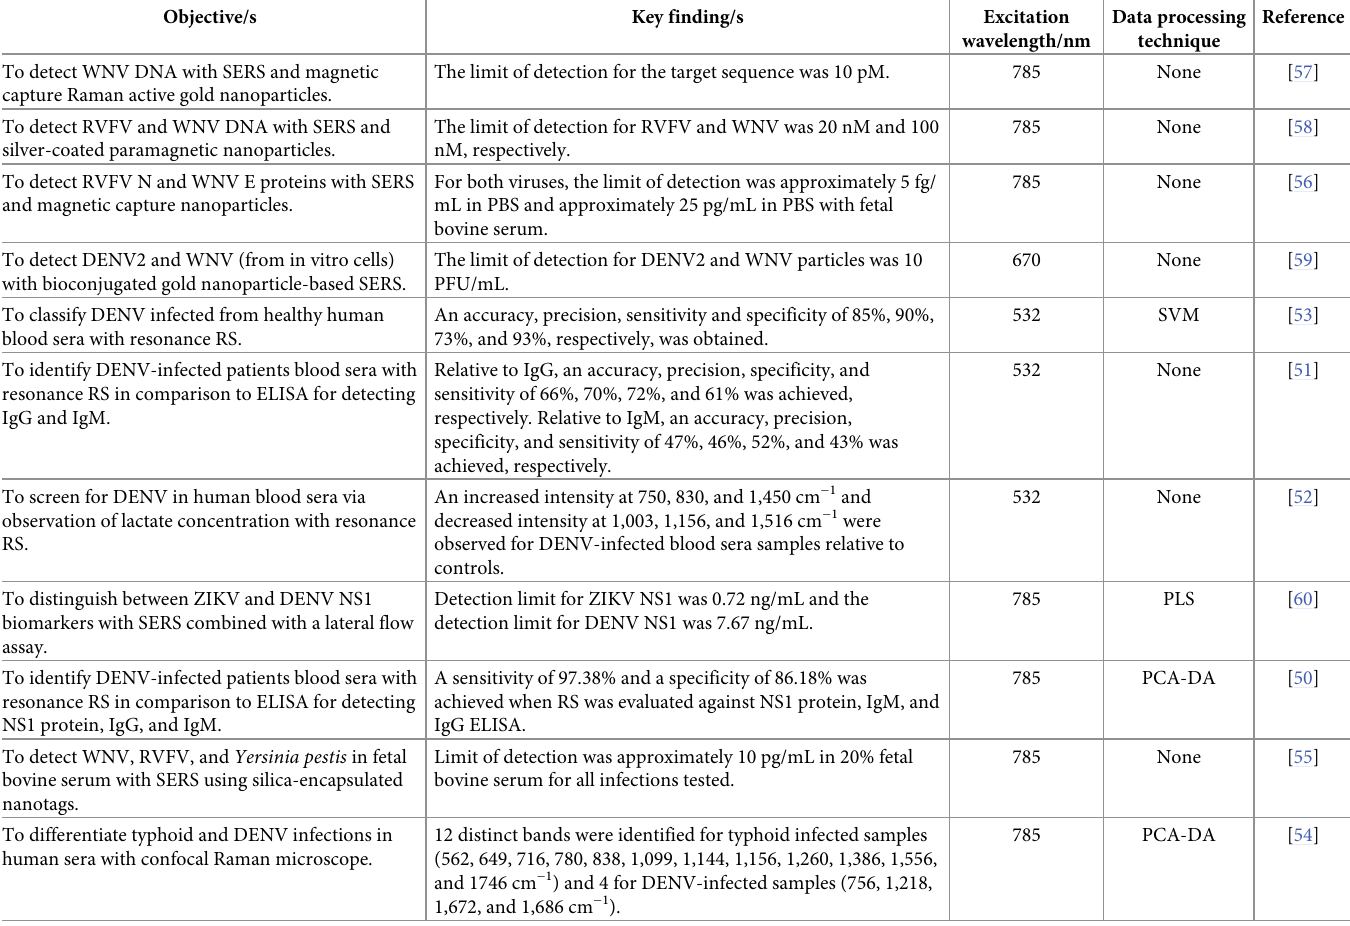
Data processing Reference wavelength/nm technique